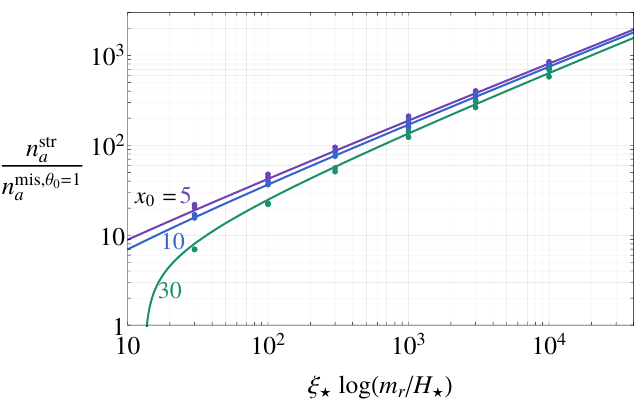
Figure 3: The late time ratio between the axion number density from strings and from = 1) as a function of ξ misalignment (with θ (cid:63) log (cid:63) for varying x 0 (the IR cutoff of the axion 0 spectrum in units of Hubble) and fixed α = 8 (the power law controlling the temperature- dependence of the axion mass). The data points are the results from simulations with statis- tical errors, and the curves correspond to the analytic prediction of eq. (5) (see Appendix E.1 and eq. (36) for more